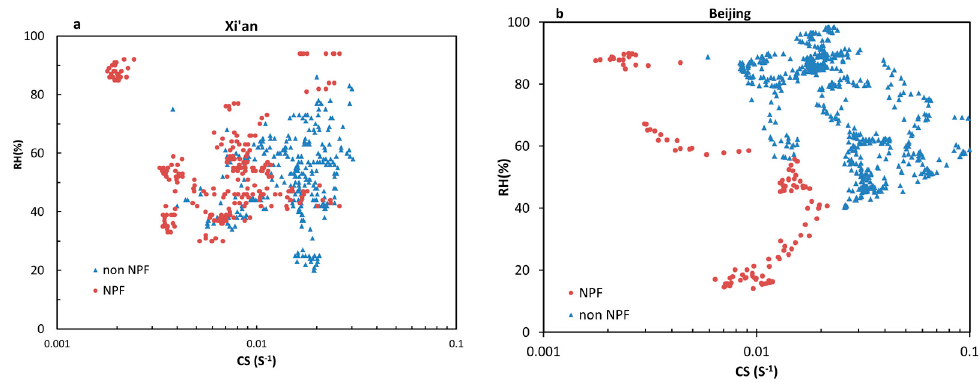
Figure 6. Relationship between the relative humidity (RH) and CS during NPF and non-NPF events for Xi’an ( a ) and Beijing ( b ).